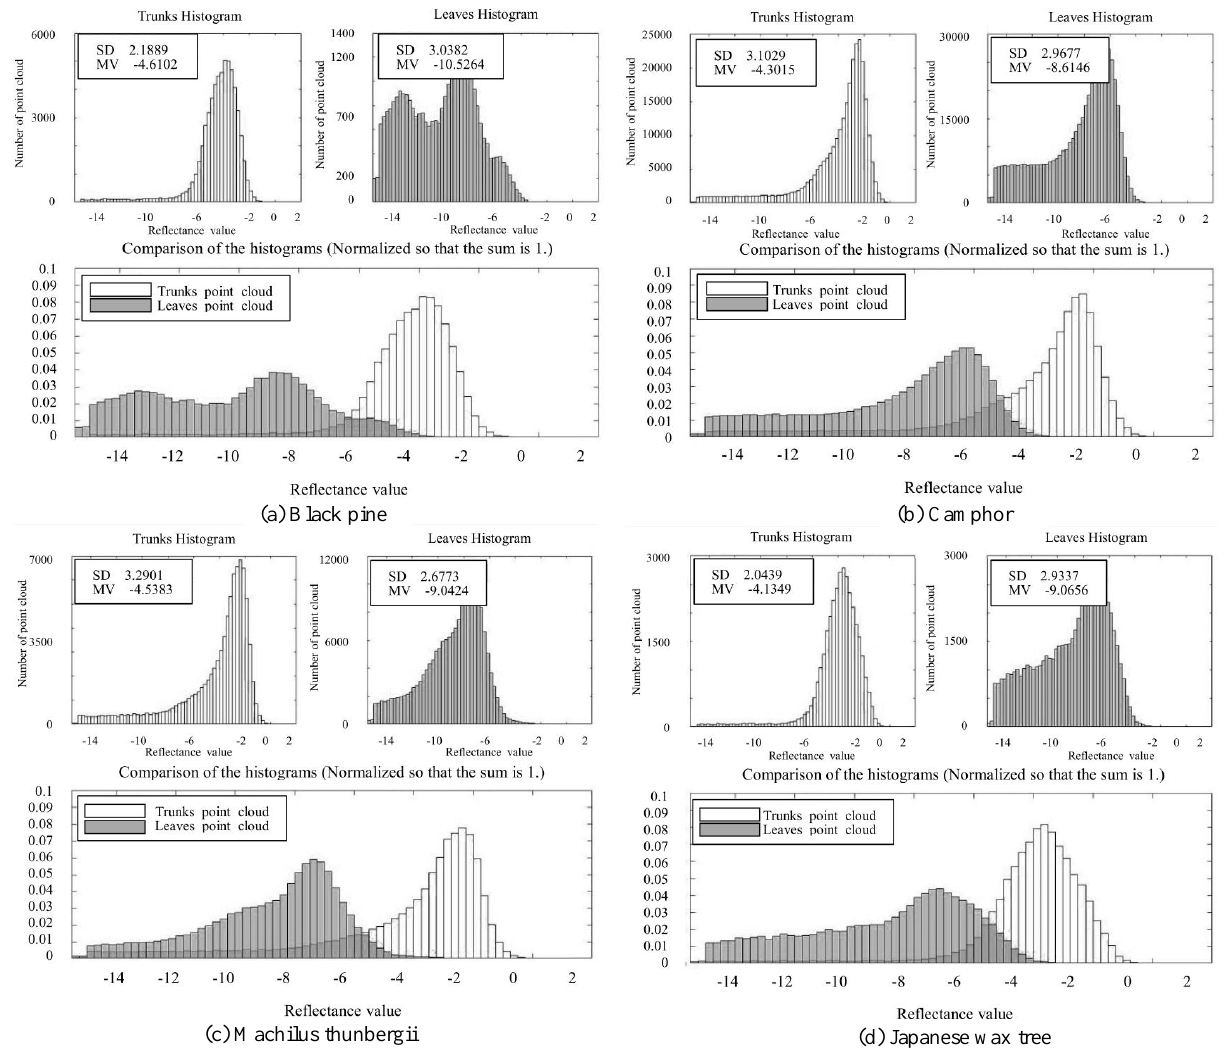
Figure 4. Reflectance histogram of each tree species